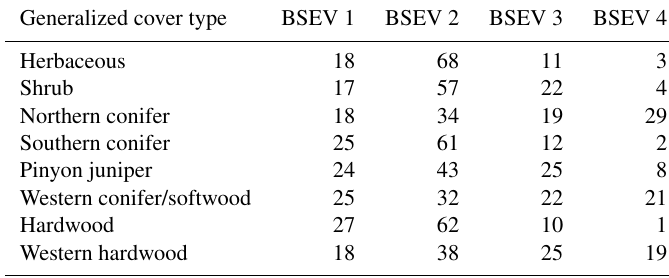
Table 2. MTBS burn severity class percent distribution by generalized cover types for 2003–2013.